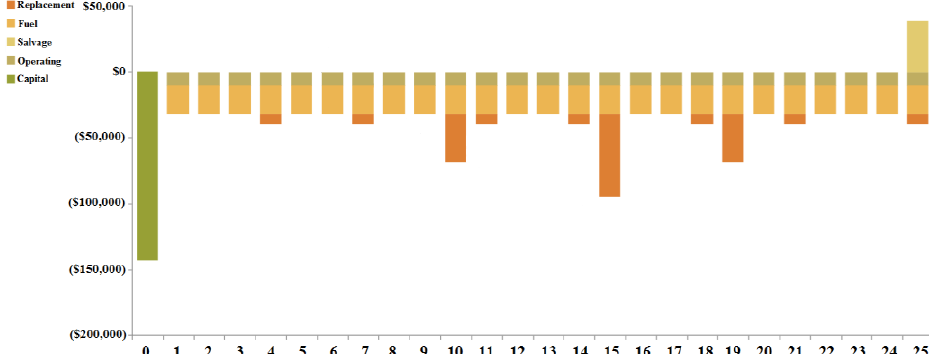
Figure 14. Total cash-flow study for case I (Ba/Bi/H).